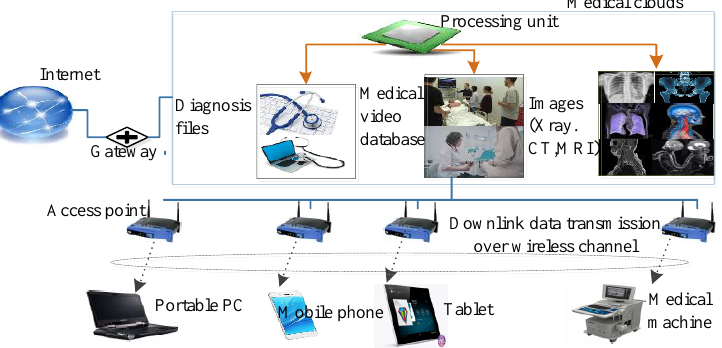
Figure 19. Medical cloud computing system architecture.